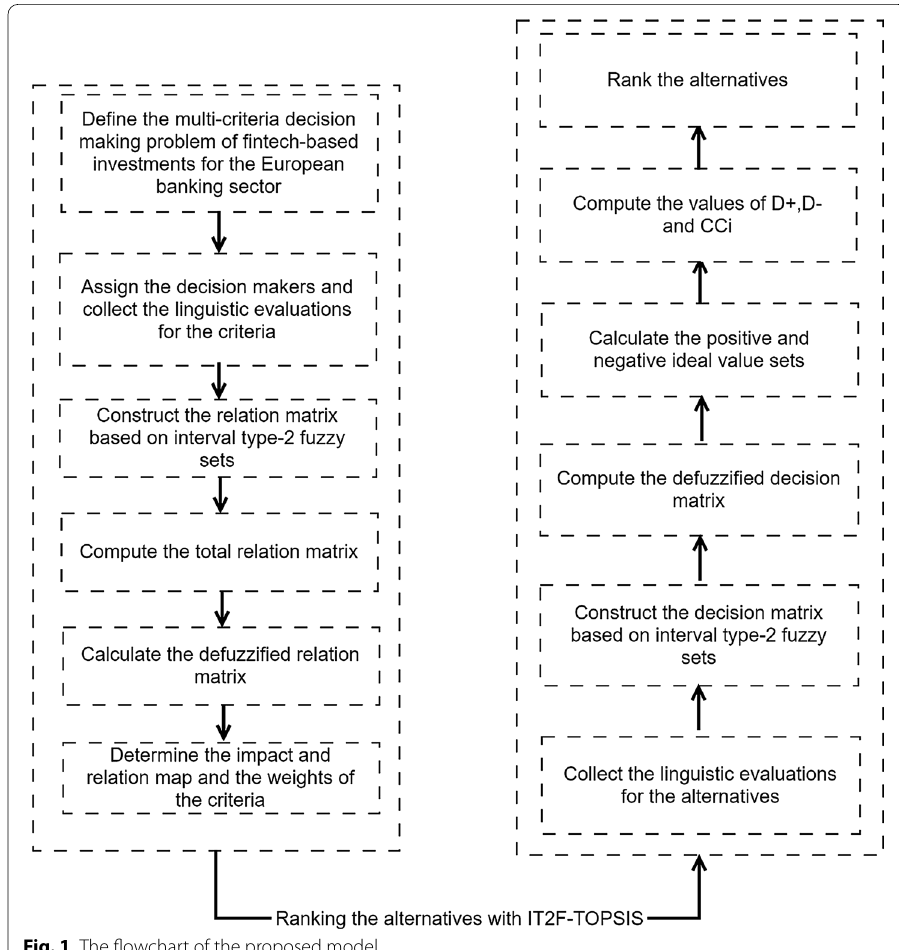
Fig. 1 The flowchart of the proposed